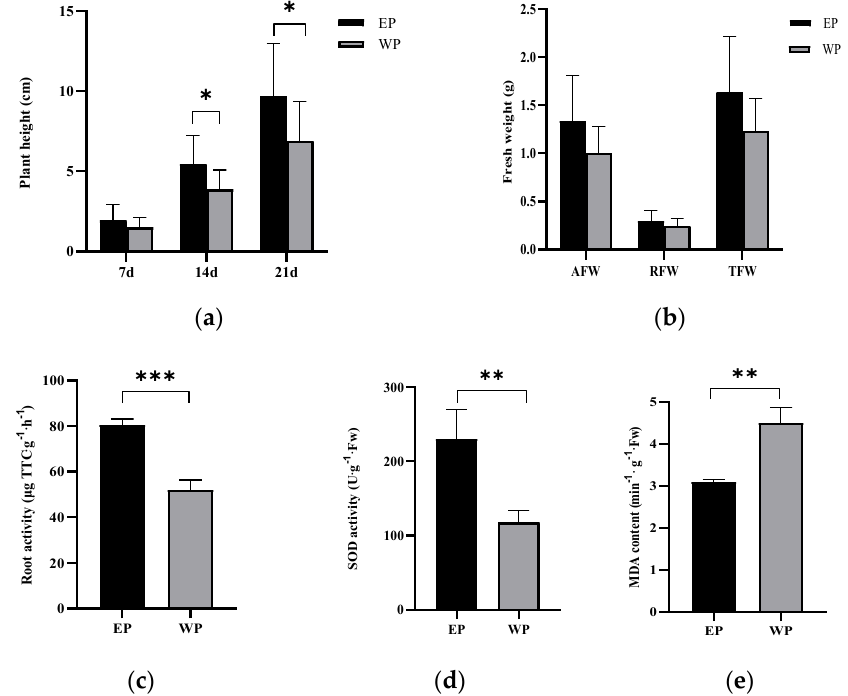
Figure 1. Effects of peanut root exudates on the growth and physiological indexes of grapevine seedlings. EP: rhizosphere soil of grapevine seedling irrigated with peanut root exudates for 28d+24d, WP: rhizosphere soil of grapevine seedling irrigated with distilled water for 28 d+24 d. *, ** or *** indicated significant difference at p < 0.05, p < 0.01, or p < 0.001 between EP and WP (Student’s t -test). ( a ) Plant height. ( b ) Fresh weight. AFW represents above-ground fresh weight, RFW represents root fresh weight, and TFW represents total fresh weight. ( c ) Root activity, ( d ) SOD activity of root, and ( e ) MDA content of root.